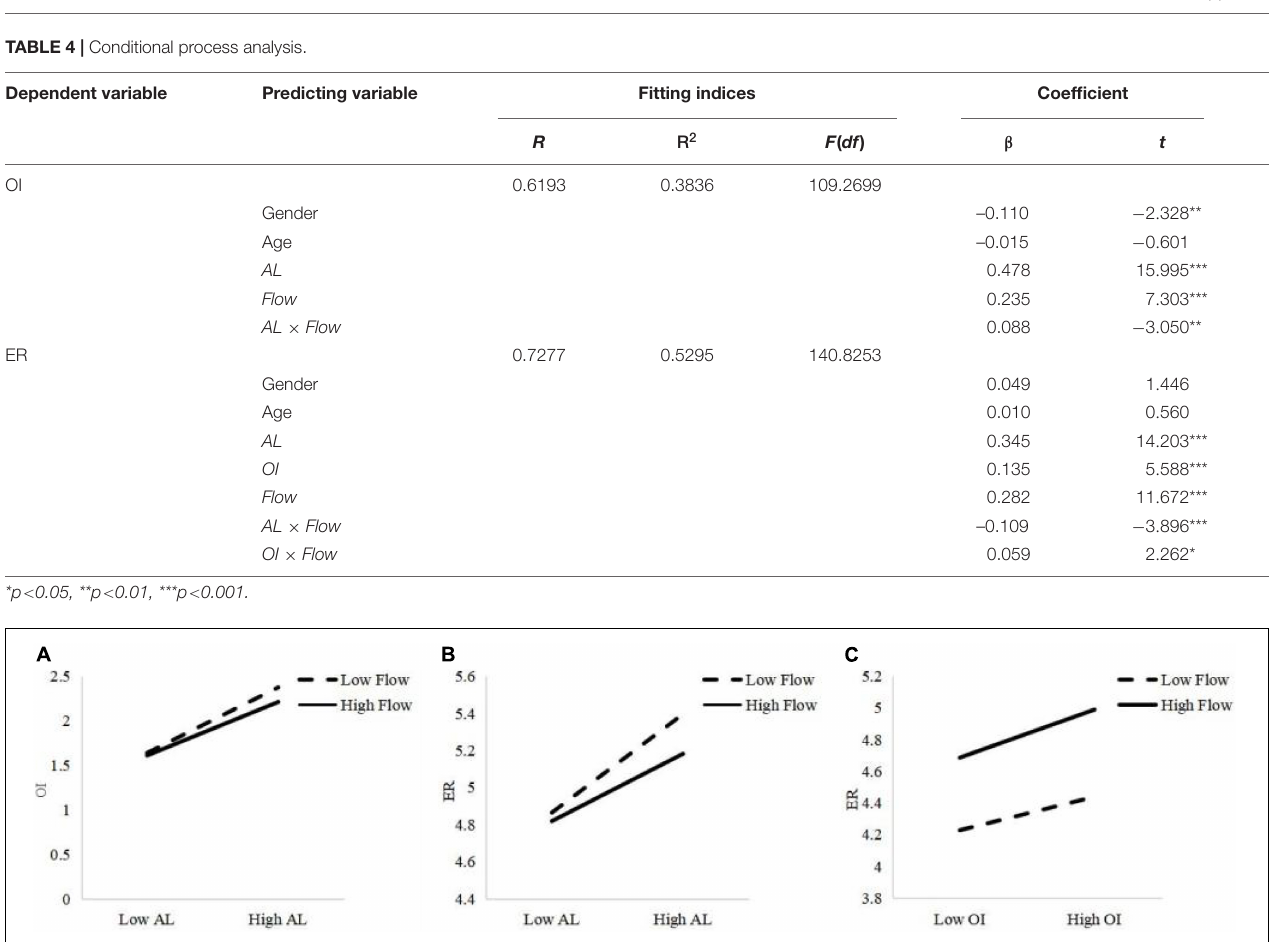
FIGURE 3 | (A) Flow’s moderation effect on the path between AL and OI. (B) Flow’s moderation effect on the path between AL and ER. (C) Flow’s moderation effect on the path between OI and